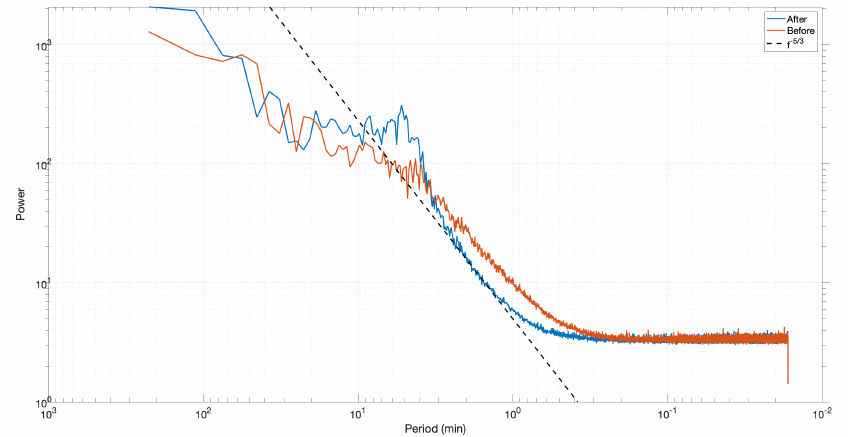
Figure 15. Mean Fourier spectrum for the two parts of the night (before and after midnight).